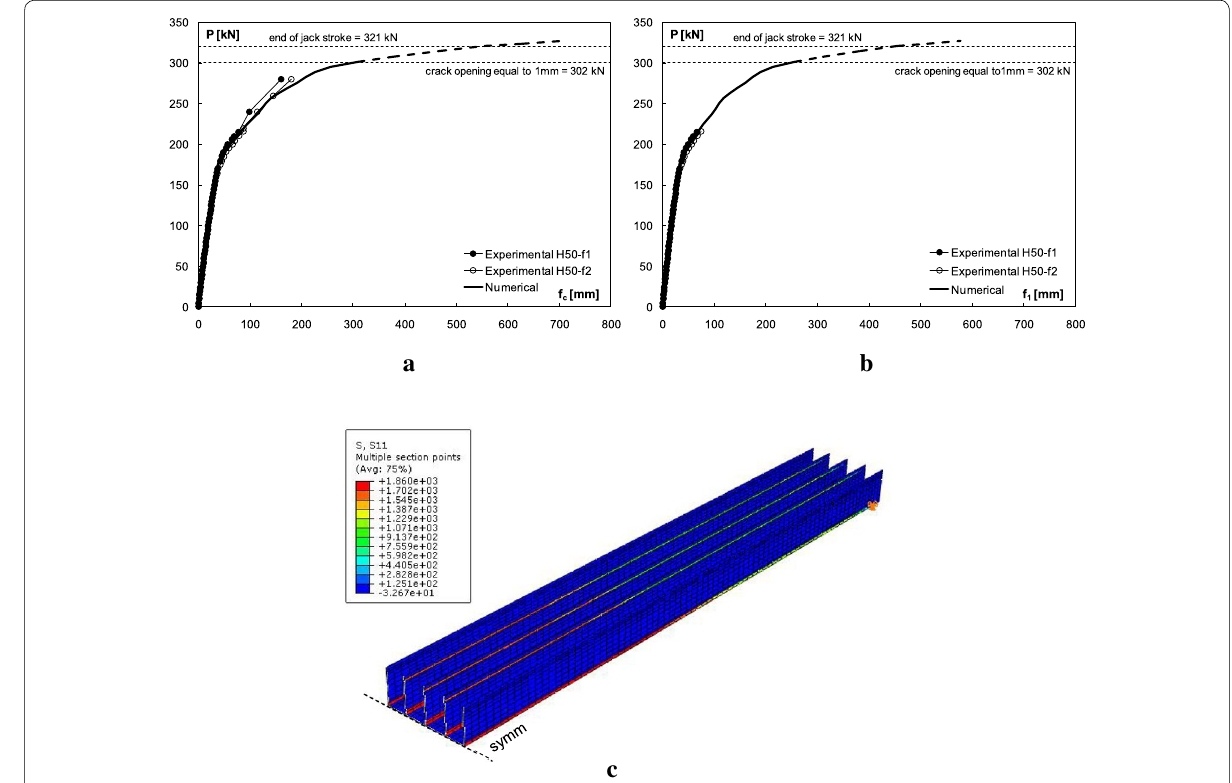
Fig. 12 Flexural tests on specimens H50-f1 and H50-f2: a , b comparisons between experimental and numerical results in terms of applied load P versus midspan deflection f c and deflection under the loading point f 1 respectively; c longitudinal stress in prestressing reinforcement in correspondence of numerical